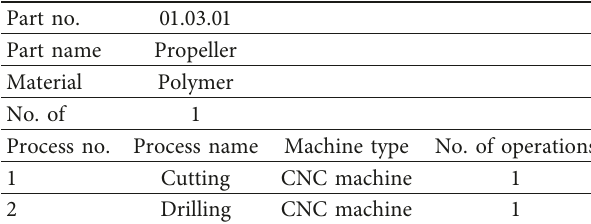
Table 6: Propeller.